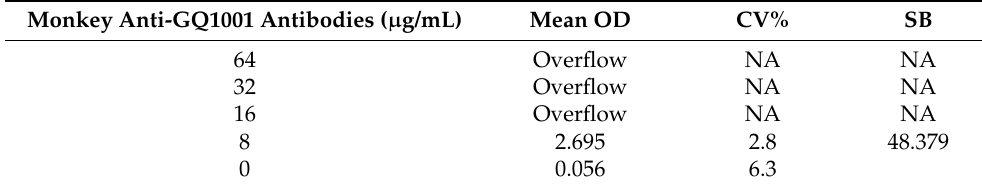
Table 4. Hook effect results.